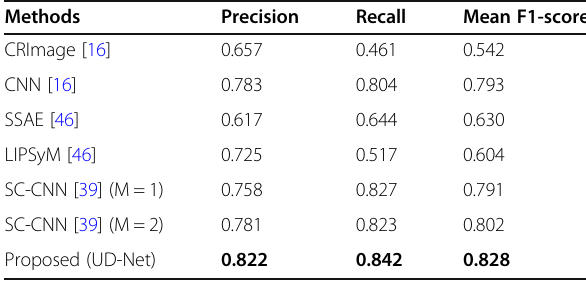
Table 3 Nuclei detection accuracy of the proposed model and comparison against existing methods Methods